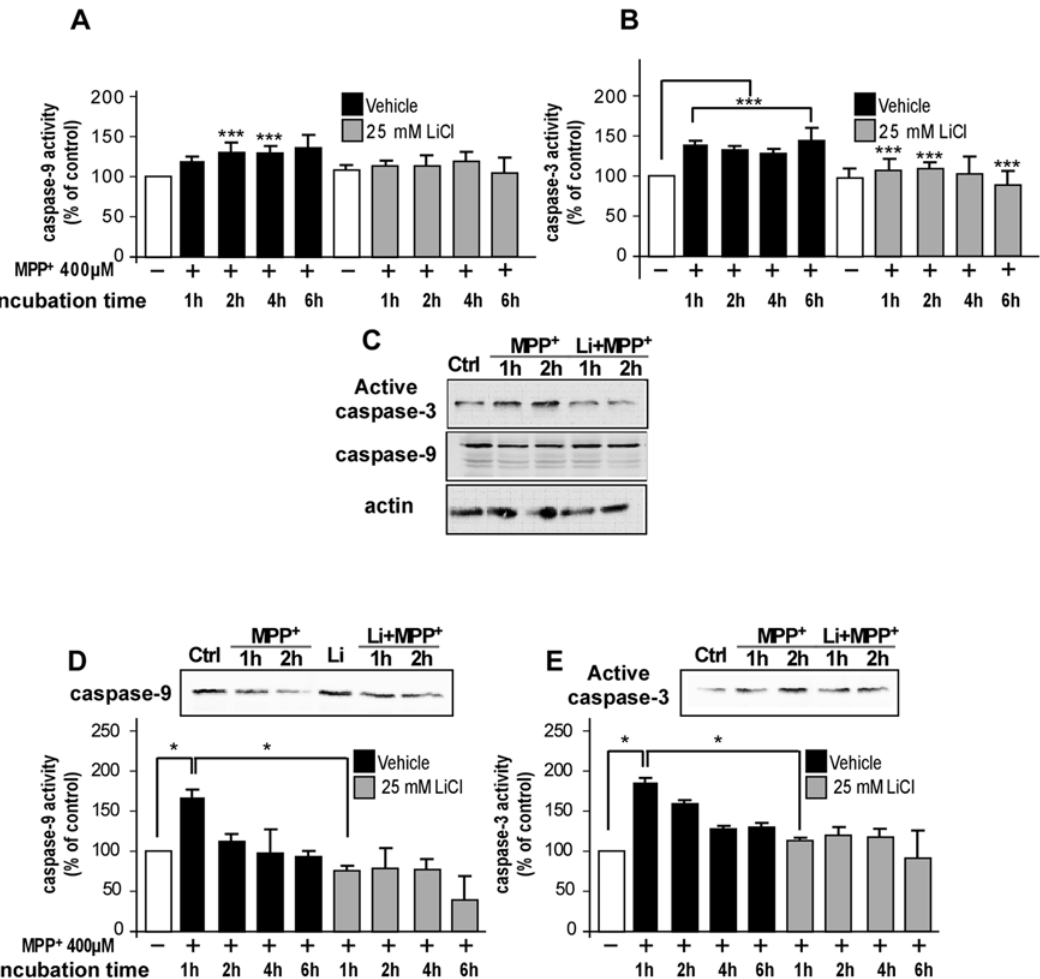
Figure 3. GSK-3 b inhibitors prevented MPP + -induced caspases-9 and -3 activation. (A, B, C) TSM1 neurons were pre-treated with saline or 25 mM LiCl and then incubated with 400 m M MPP + for indicated times (1, 2, 4, or 6 h). Intracellular caspase-9 (A) and caspase-3 (B) activities were measured by fluorescence enzymatic assay in cell homogenates. The data are expressed as the percentage of control when compared to untreated neurons and are the mean of three independent experiments with triplicate samples 6 S.D. Statistical analysis was done using Student t -test (*** p , 0.005 versus untreated sample). (C) TSM1 cells were pre-treated or not with 25 mM LiCl and incubated with saline ( ctrl ) or MPP + (400 m M) for 1 or 2 h. Total proteins (40 m g) were analyzed for active caspase-3, total caspase-9 and actin contents by Western blotting. (D, E) Primary cultured neurons were pre-treated with saline or 25 mM LiCl and then incubated with 400 m M MPP + for indicated times (1, 2, 4, or 6 h). Intracellular caspase-9 (D) and caspase-3 (E) activities were measured by fluorescence enzymatic assay in cell homogenates. The data are expressed as the percentage of control when compared to untreated neurons and are the mean of three independent experiments with triplicate samples 6 S.D. Statistical analysis was done using Student t -test (* p , 0.05 versus untreated sample). Total caspase-9 (D) and active caspase-3 (E) contents were analyzed by Western blotting of primary neurons pre-treated or not with 25 mM LiCl and incubated with saline ( ctrl ) or MPP + (400 m M) for 1 or 2 h.